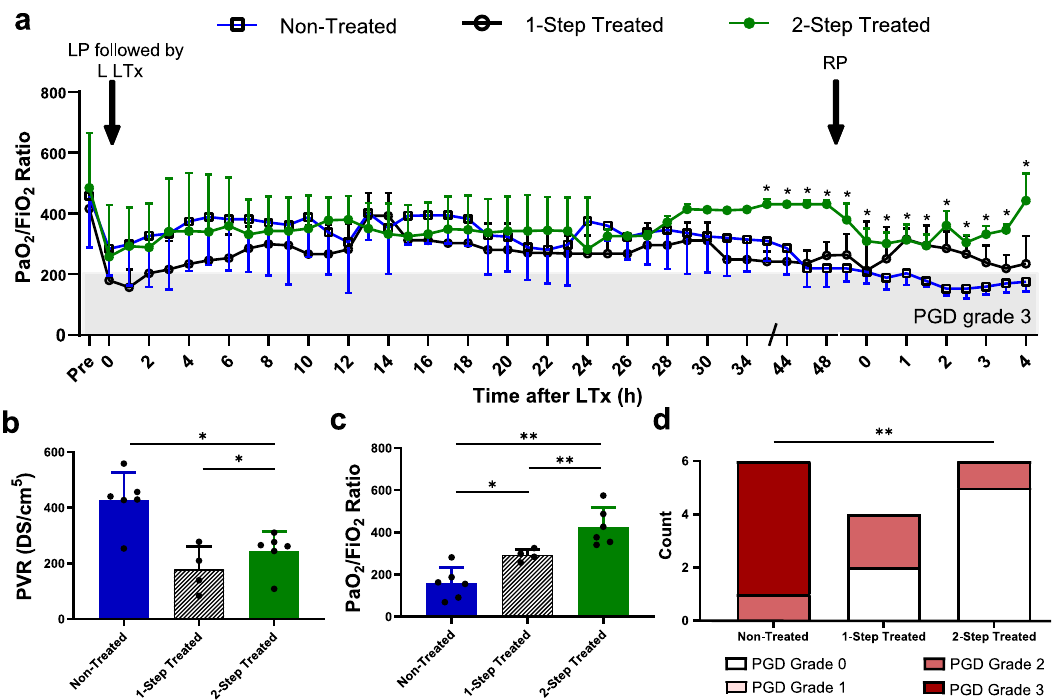
Fig. 5 Reduced primary graft dysfunction (PGD) in treated recipients. a PaO 2 /FiO 2 ratios for all groups were followed from before transplantation in the recipient to 48 h of follow-up. The fi rst arrow indicates a left pneumonectomy followed by left lung transplantation (LP followed by L LTx) and the second arrow depicts the time of right pneumonectomy (RP). Statistical signi fi cance applies to direct comparison of two-step treatment to the non-treated